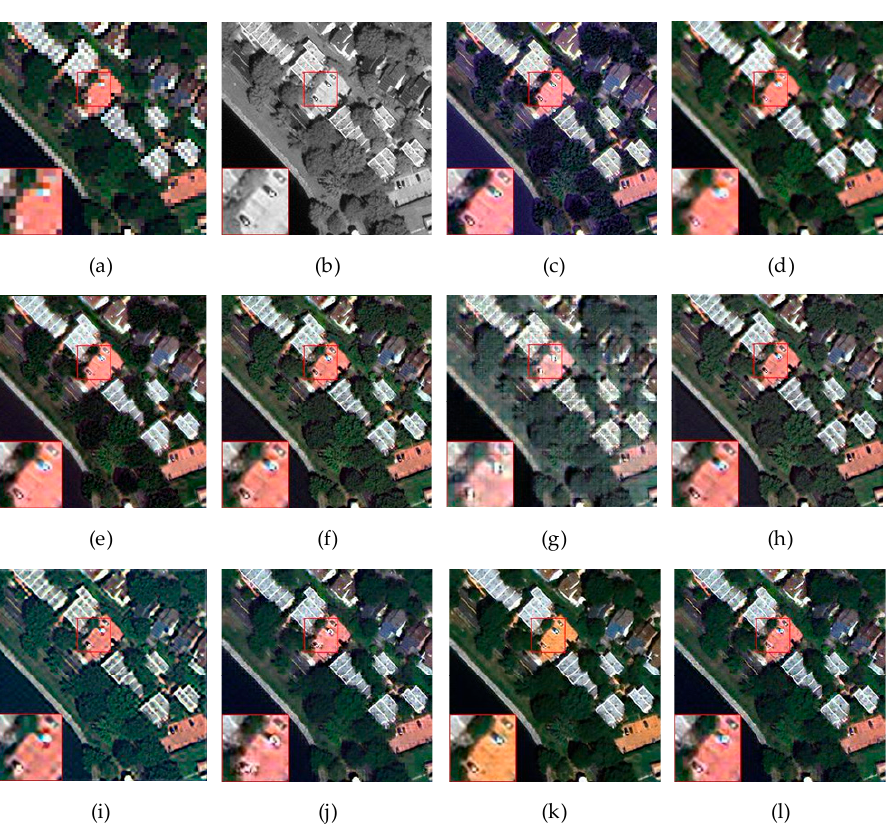
256 size. ( a ) Reference ×